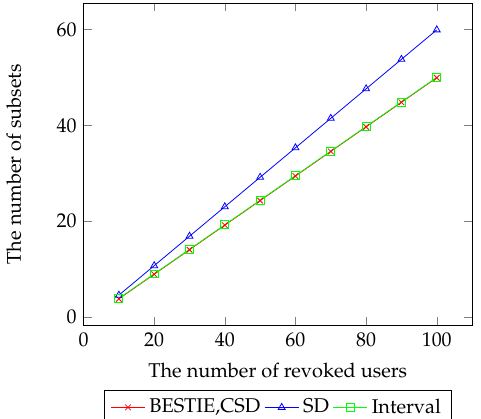
Figure 3. The number of subsets in the broadcast encryption scheme for tiny Internet of Things (IoT) equipment (BESTIE), CSD, SD, and interval schemes for random revocation (2 128 users).